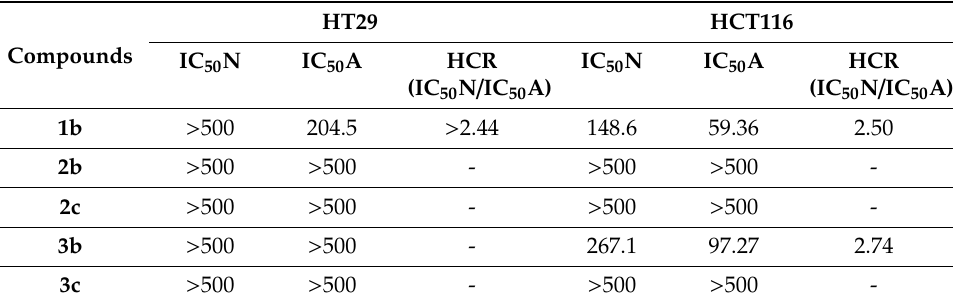
Figure 3. Lethal concentration 50 (LC 50 ) values of the prodrugs. The LC 50 doses of the compounds were calculated based on the 50% mortality of the developing larvae at the end of five days after the exposure of embryos to different concentrations of inhibitors. ( A ) The ranges of LC 50 values of compound 4b (< 500µM concentration). ( B ) The LC 50 value for compound 5b was below 1000 µM and ( C ) compound 1b showed an LC 50 value of about 1400 µM. The LC 50 doses were determined after three independent experiments with similar experimental conditions (N = 72 larvae).